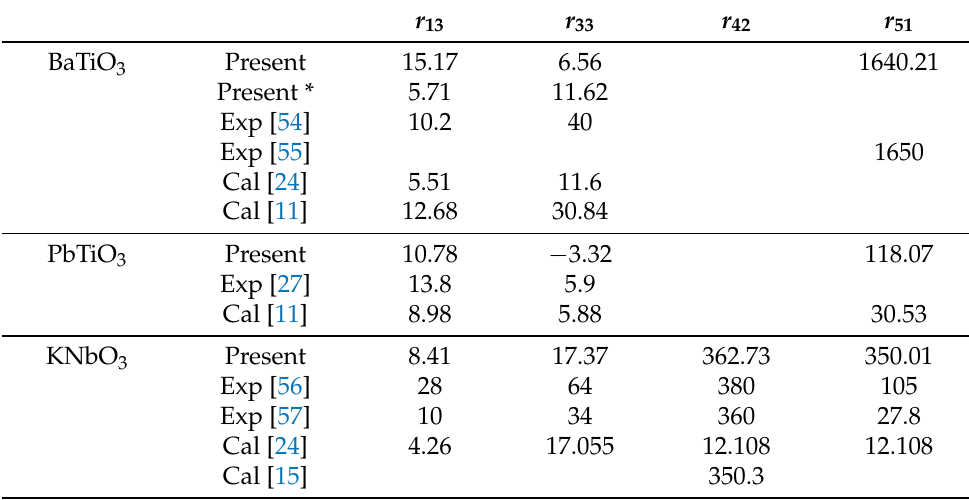
Table 3. EO coefficients (pm/V) of BTO, PTO, and KNO calculated using (16). Present and other EO coefficients determined elsewhere: see the associated